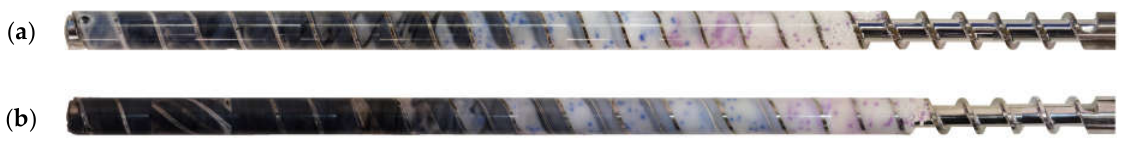
Table 2. Modeled properties of processed high‐impact polystyrene (HIPS) (Styron 478).